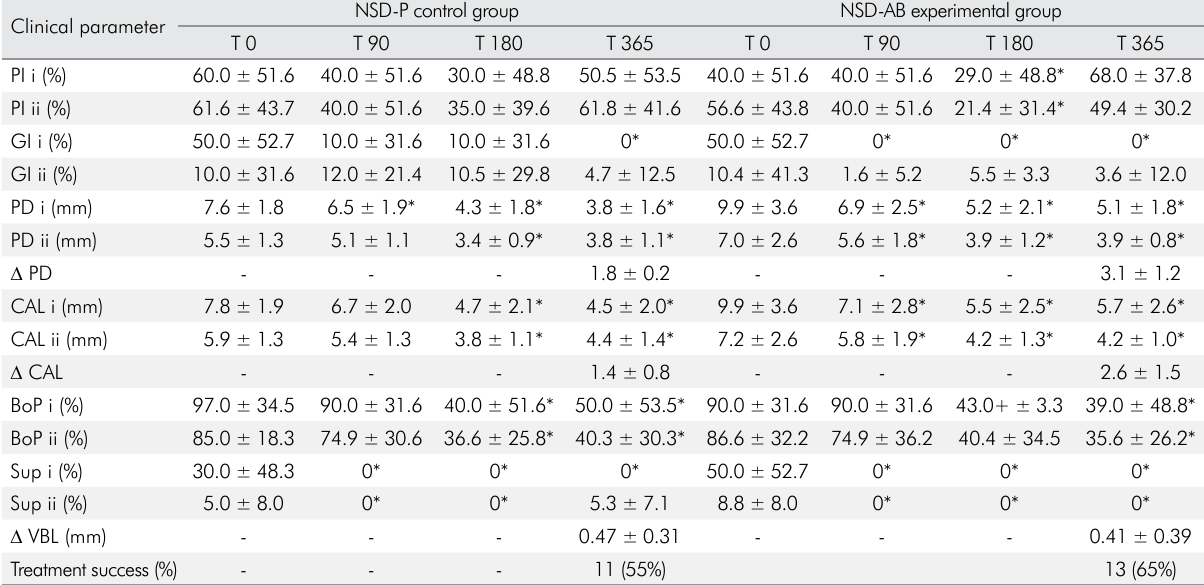
Table. Clinical parameters (mean ± SD) of test sites (i) and six implant sites (ii) in the NSD-P control group and NSD-AB experimental group (n = 20/group) during the evaluation